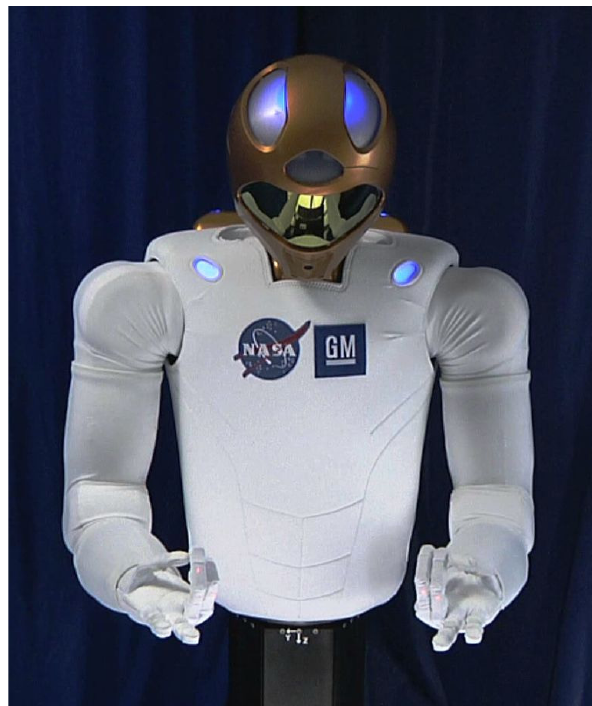
Figure 1. The secondary fingers of R2 are underactuated.